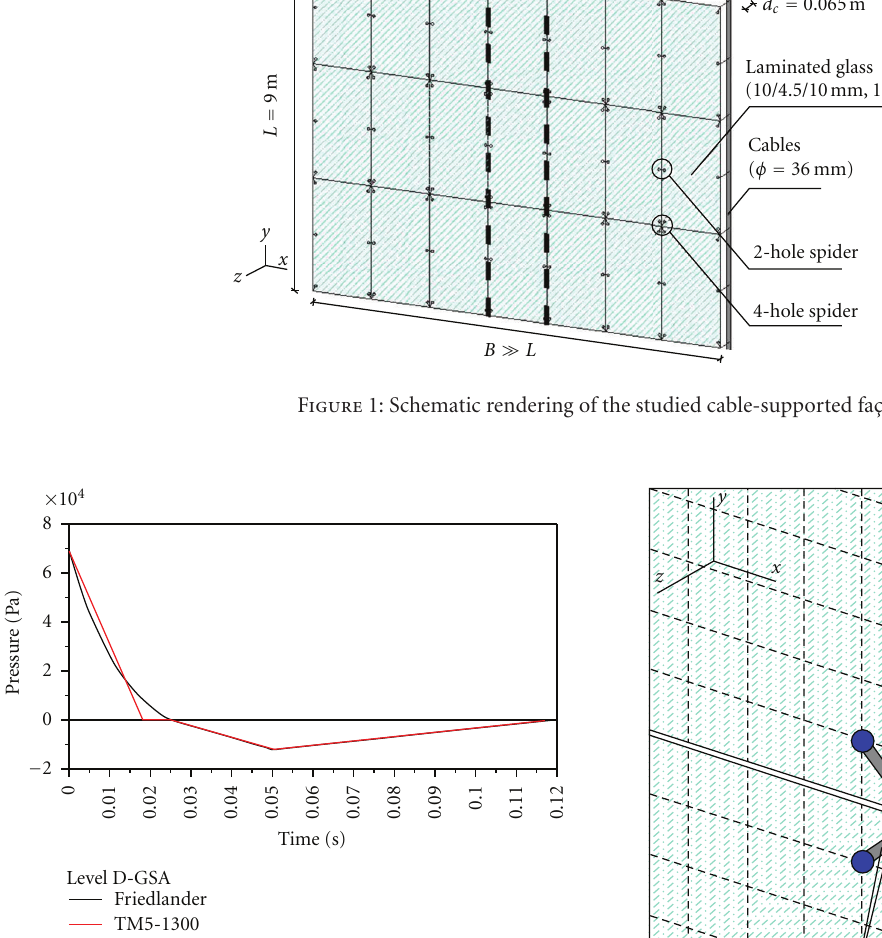
Figure 2: Pressure-time history for a Level D-GSA air blast loading [10].